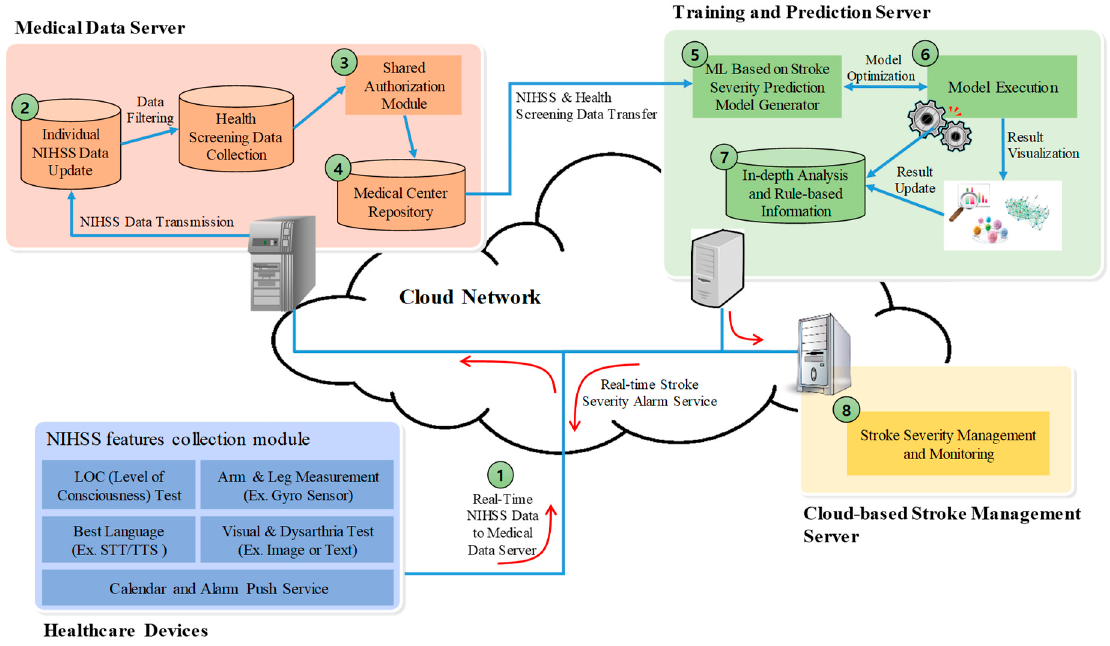
Figure 1. The proposed system architecture for stroke severity prediction and analysis of the elderly.